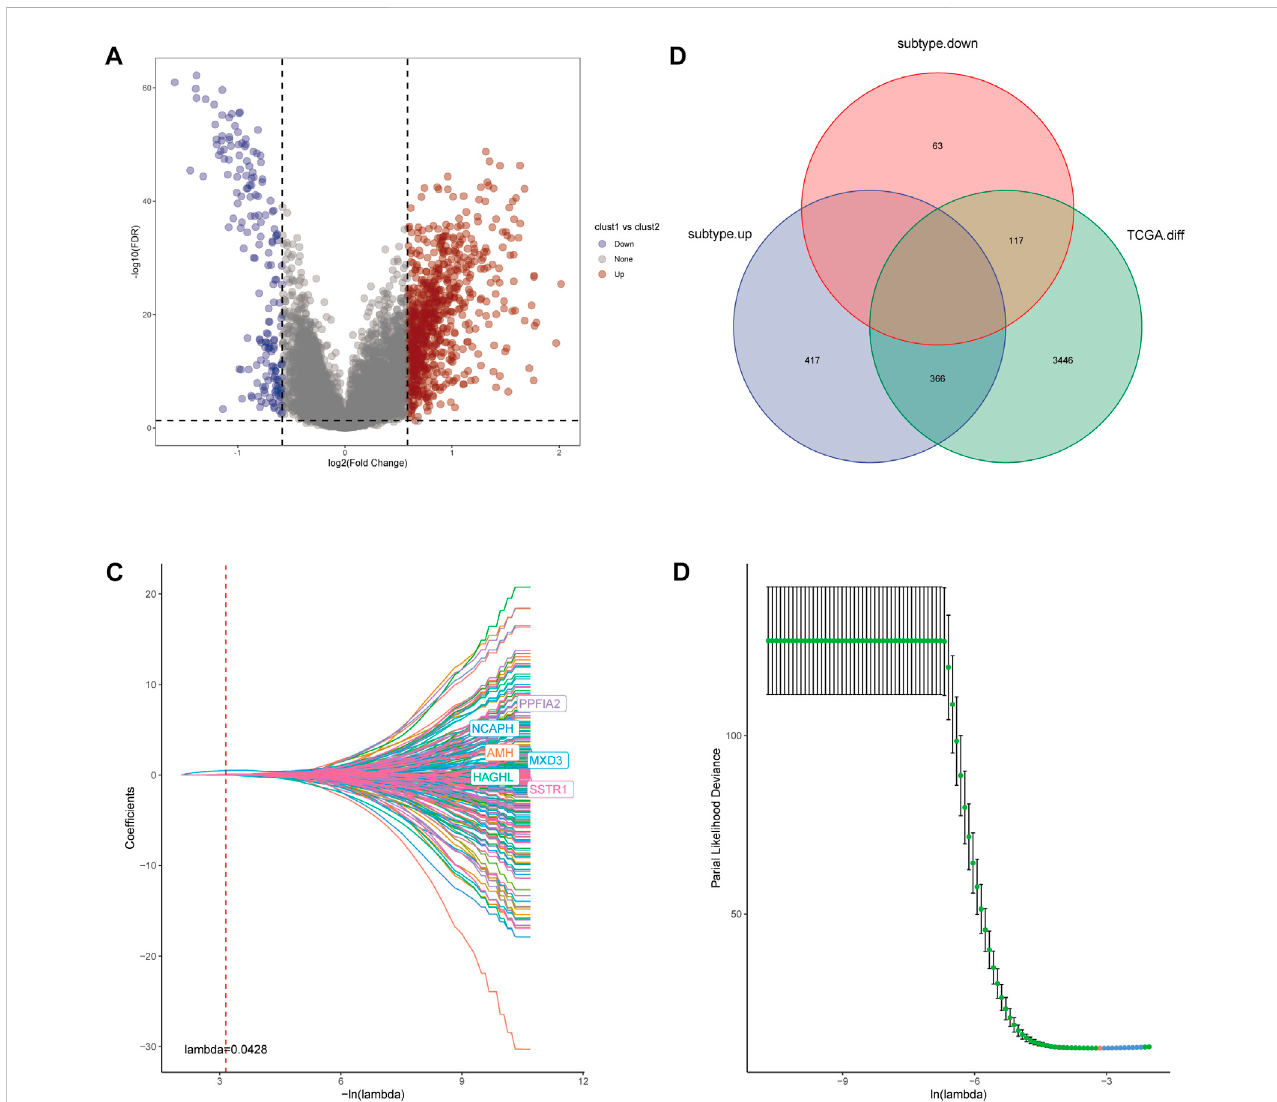
FIGURE 5 (A) VolcanodiagramofDEGsbetweenthetwoCRGs-relatedsubtypes. (B) TheVenndiagramdemonstrated483genesobtainedaftertheintersectionof DEGs between the two subtype and DEGs between Prostate tumor and normal part in TCGA database. (C,D) LASSO Cox regression was utilized to construct the signature and the best log( λ ) value was